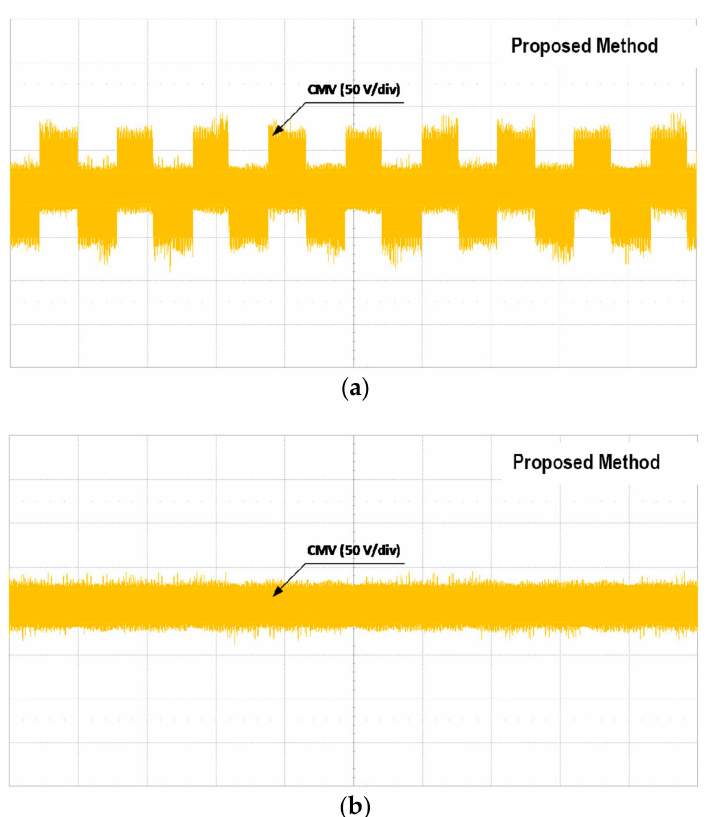
Figure 13. Experimental results for common mode voltage: ( a ) The conventional method and ( b ) the proposed method.